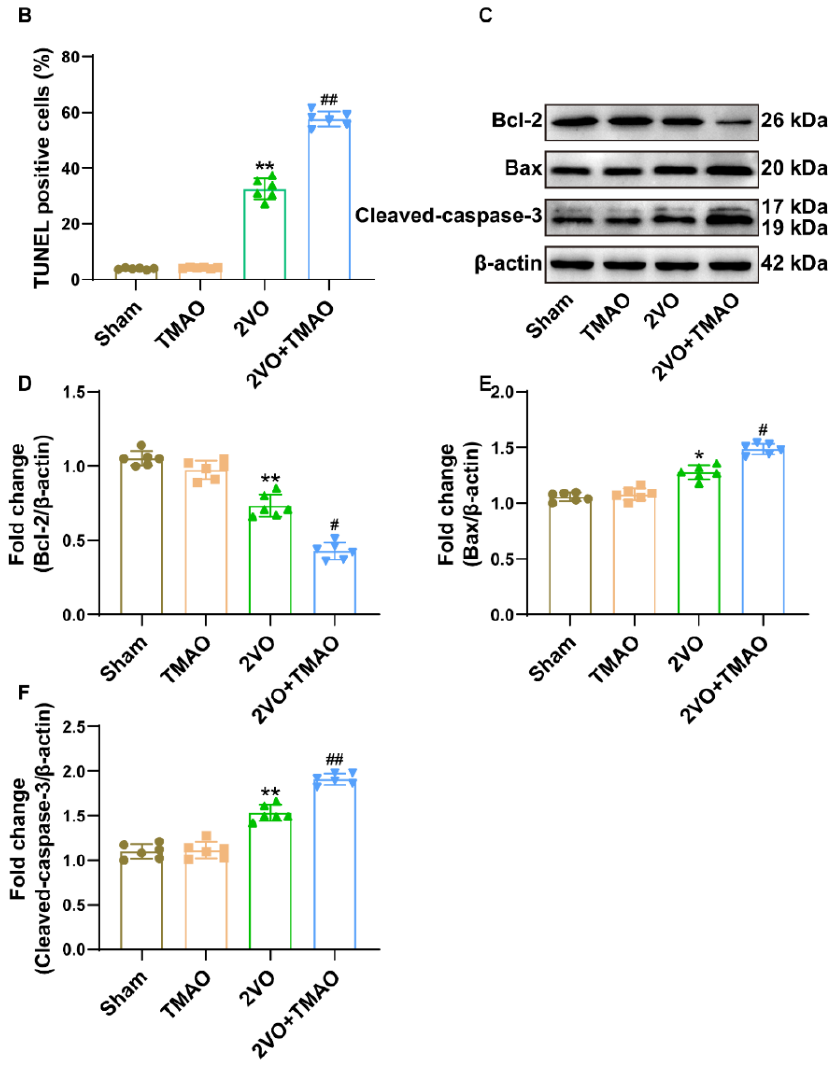
Figure 4. TMAO induced neuronal apoptosis within 2VO rats. ( A ) TUNEL staining images of the hippocampal CA1 area. Scale bar, 20 µ m (n = 6). ( B ) Quantification of TUNEL-positive cells is shown as a bar chart (n = 6). ( C ) Representative bands of Bcl-2, Bax, and cleaved caspase-3 protein expression within the hippocampi of the rats across the groups. β -actin served as a loading control (n = 6). Quantification for ( D ) Bcl-2, ( E ) Bax, and ( F ) cleaved caspase-3 protein expression is shown as a bar chart (n = 6). Datasets reflect the mean ± SD. * p < 0.05 and ** p < 0.01 versus the Sham group; # p < 0.05 and ## p < 0.01 versus the 2VO group.